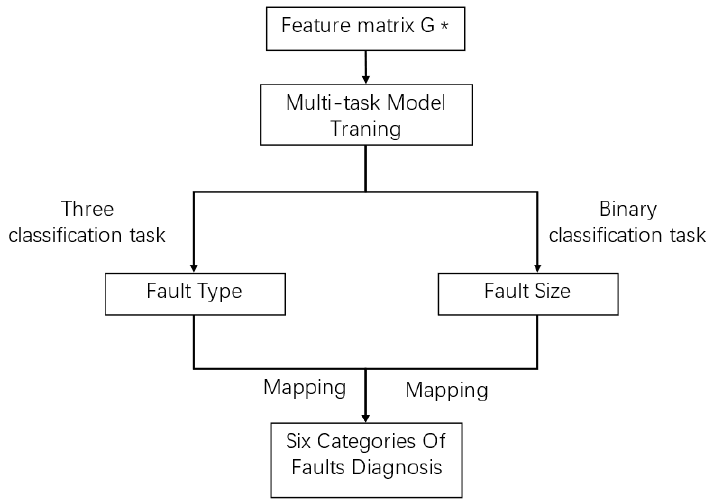
Figure 4. The multi-layer attention convolution model.